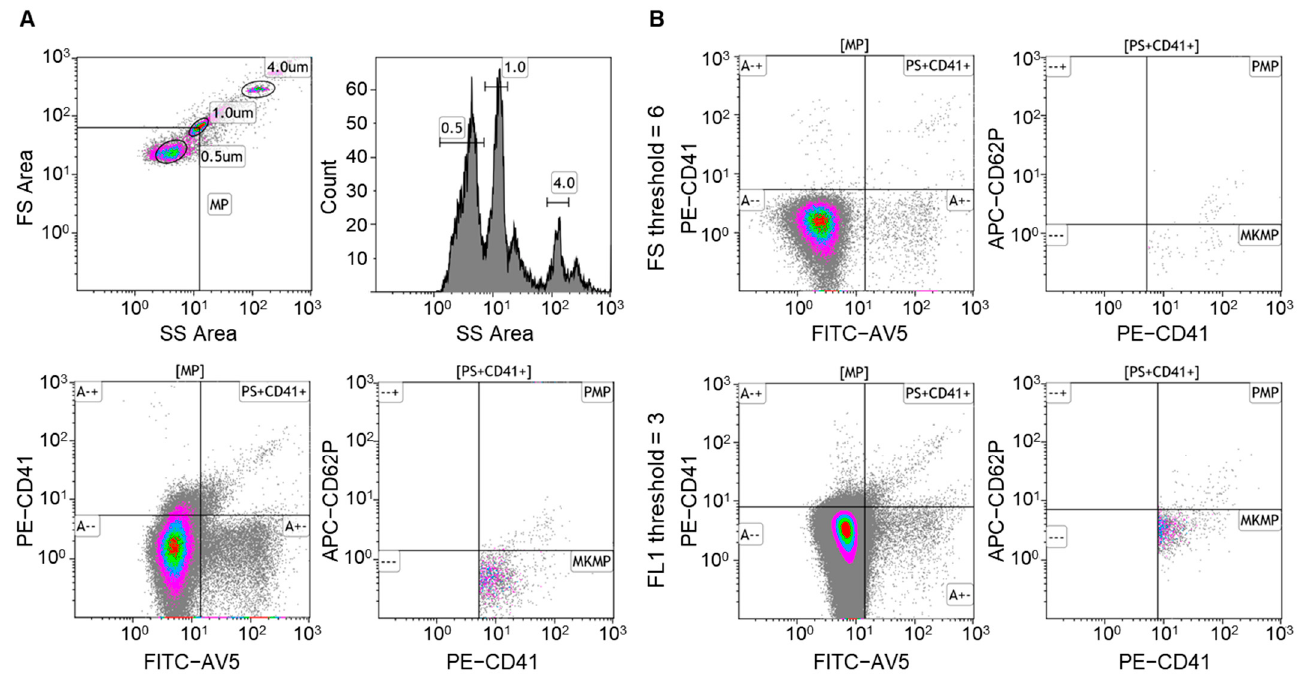
Figure 1. Flow cytometry analysis of plasma MPs: ( A ) Calibrated latex beads (0.5 and 1.0 μ m) were used to determine the MP gate (particle size < 1.0 μ m). Four μ m counting beads were shown in the upper right corner of the FSC/SSC view. Annexin V + CD41 + events were analyzed in the MP gate. The numbers of PMPs (CD41 + CD62P + ) and MKMPs (CD41 + CD62P − ) were determined based on the counting beads; ( B ) MPs in PFP samples were analyzed by Gallios Flow Cytometer under two dis- crimination settings: forward light scatter (FS) threshold = 6 (top panels) and fluorescence parameter 1 (FL1) threshold = 3 (bottom panels). More MP events were detected using FL1 threshold than FS threshold. PMPs, platelet-derived microparticles; MKMPs, megakaryocyte-derived microparticles.